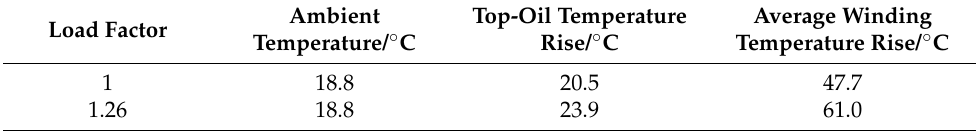
Table 5. Steady state temperature rise